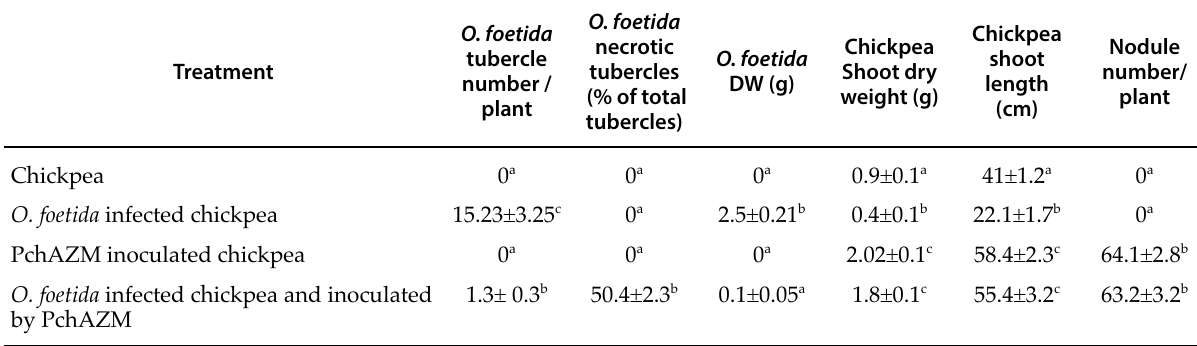
Table 1. Impact of root inoculation by rhizobia on Orobanche tubercle formation and dry matter in pot experiments